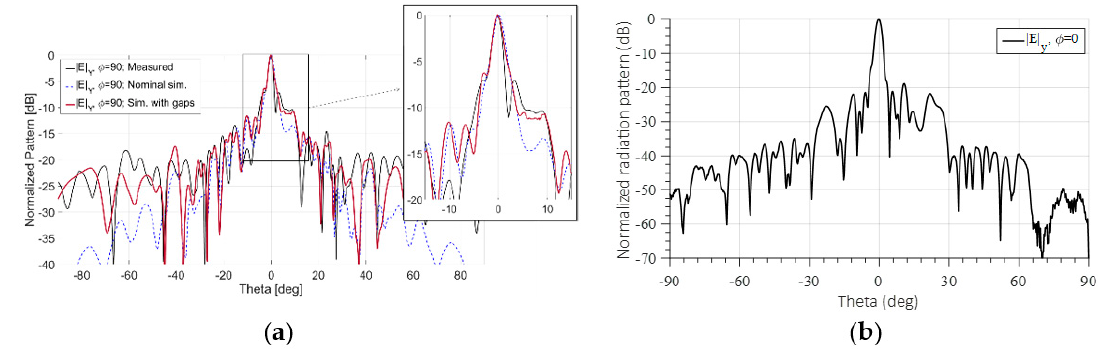
Figure 6. Normalized radiation pattern of the proposed configuration at 20 GHz. ( a ) E-plane; ( b ) H-plane (measurement).